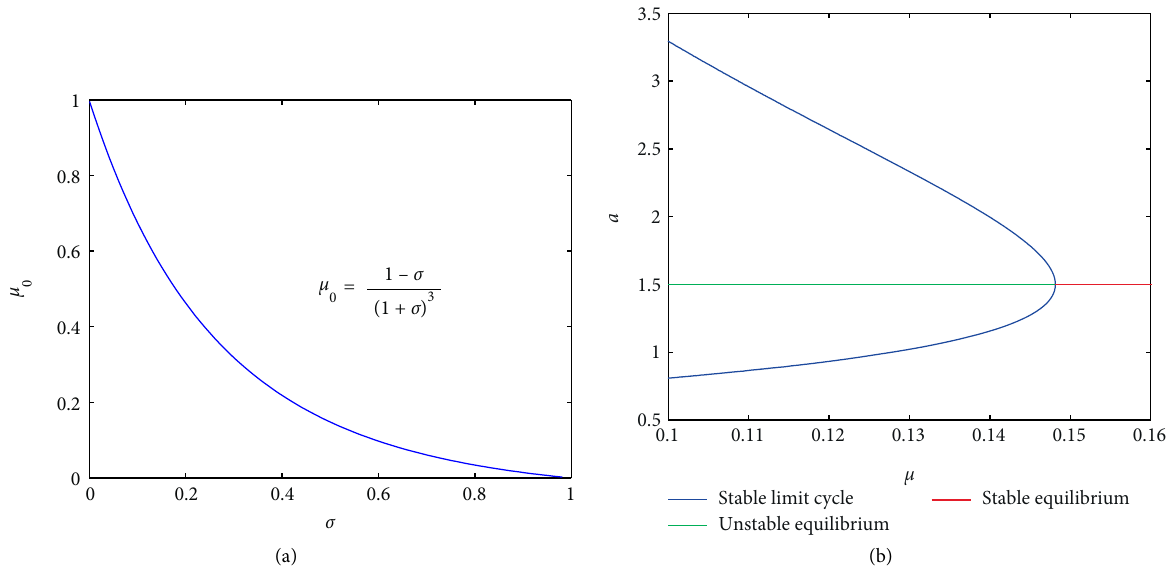
Figure 1: (a) The supercritical Hopf bifurcation diagrams of system (4) and (b) Hopf bifurcation on a two-dimensional system in polar coordinates of system (4).